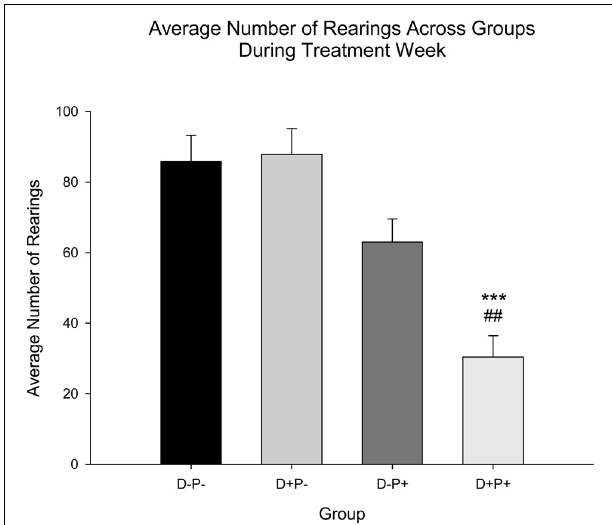
FIGURE 7 | Average number of rearings during treatment week. The number of rearings was only significantly reduced during Treatment Week in the pregnancy termination group (D+P+) relative to all other groups (D − P − , D+P − , D − P+). n = 19–21 rats/group; ∗∗∗ p < 0.001 (Relative to D − P − and D+P − ); ## p < 0.01 (Relative to D − P+). Data is expressed as mean ±